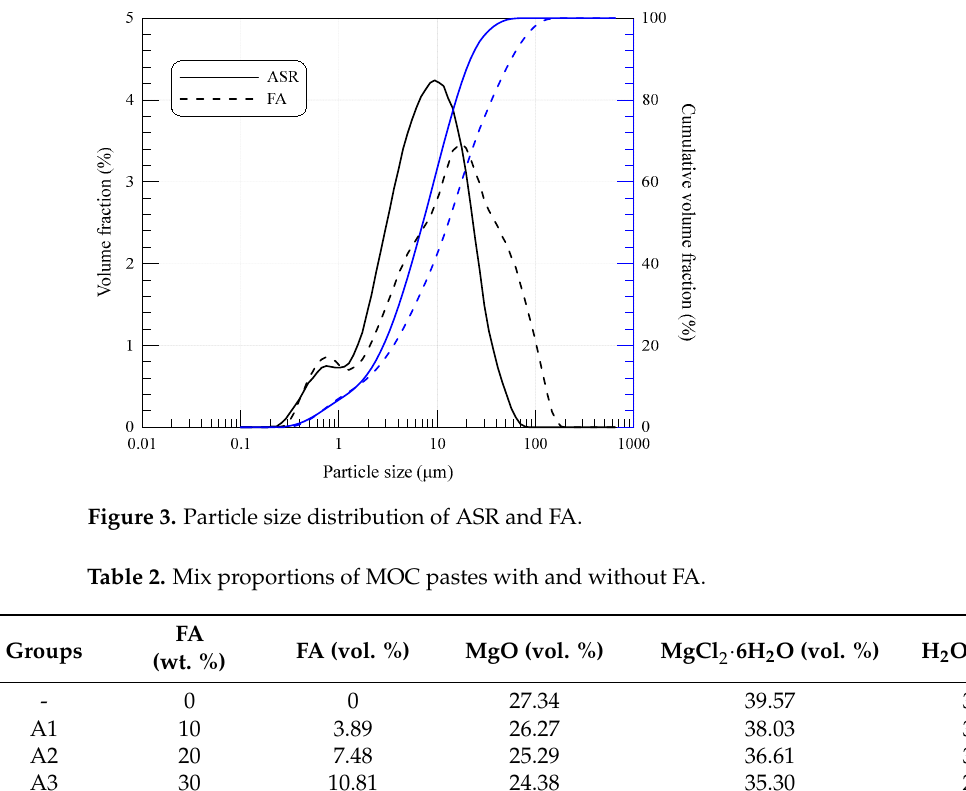
Figure 2. Micro morphologies of solid wastes ( a ) FA and ( b ) ASR.